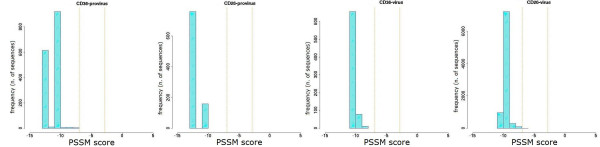
PSSM score distribution of V3 amino acid sequences from Pt.3. The PSSM score distribution of all variants from CD36- and CD26-provirus detected in Pt.3 at the moment of therapy interruption are shown together with those from CD36- and CD26- captured virus present one month after therapy stop. Vertical orange lines indicate percentiles for predicted co-receptor usage as in Fig. 6.